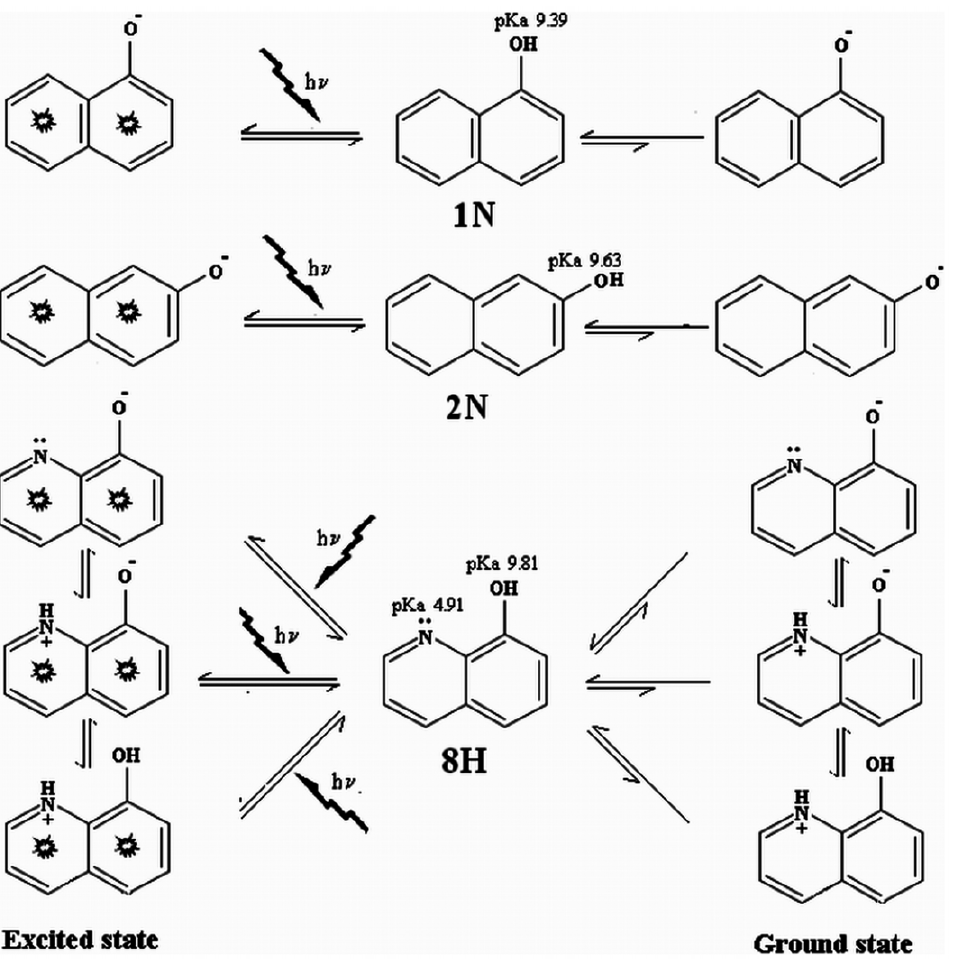
Figure 14. pKa dependent dissociation equilibrium of pollutants in ground and excited states. In ground states the equilibrium shifts predominantly towards non-ionic species whereas in excited states the equilibrium is maintained between non-ionic and ionic species.